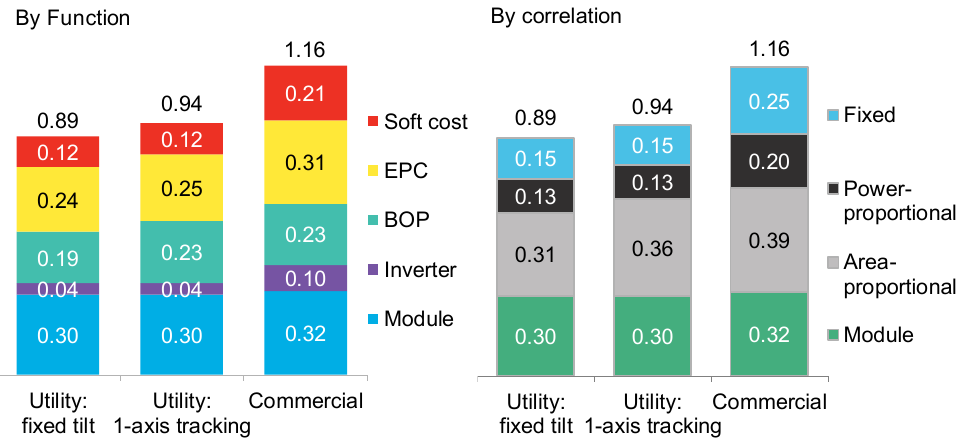
Figure 6. 2018 benchmark of PV system capex ($/W DC ). Source: BloombergNEF Note: The values presented in the right-hand chart are estimated from BloombergNEF benchmark costs. Module efficiency is 17.7% for the benchmark projects.